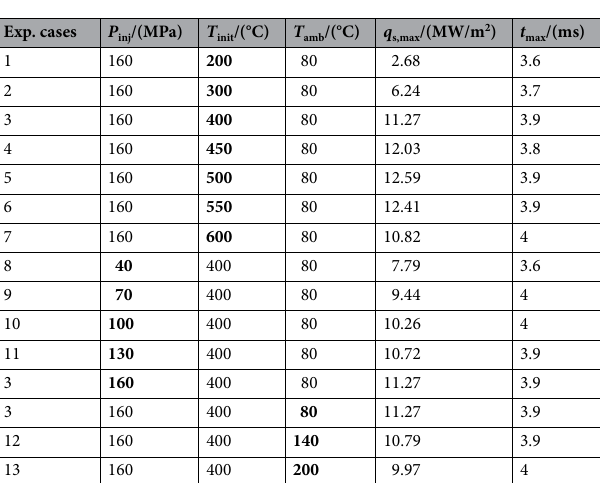
Table 4. Values of the maximum surface heat flux ( q s,max ) and the time ( t max ) of its occurrence for various experimental conditions. Significant values are in [bold].